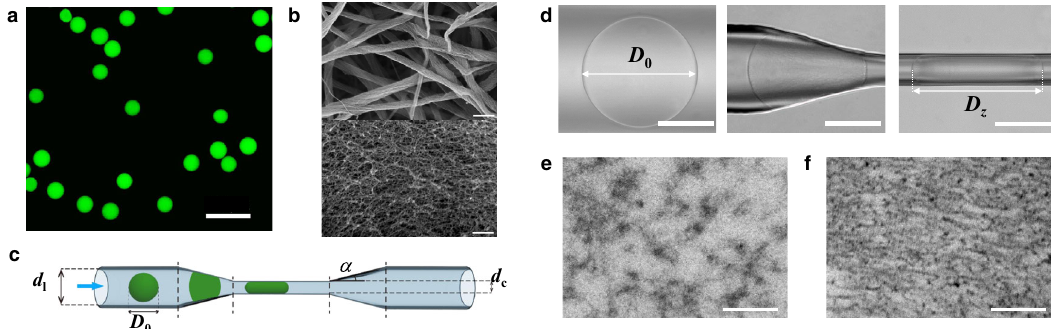
Fig. 1 Properties of fi brin microgels. a Fluorescence microscopy image of fl uorescein isothiocyanate (FITC)-labeled RMs suspended in TBS. The scale bar is 500 μ m. b SEM images of the SM (top) and RM (bottom). The scale bars are 500 nm. c Schematic of the micro fl uidic channel containing a channel-at- large (diameter of d l ) and a constriction with the entrance angle, α , of the tapered region of 15° and a diameter, d c = 65 μ m. d Left-to-right: optical microscopy images of RM (diameter of D 0 ) in the channel-at-large, the tapered zone, and in the constriction (length of con fi ned gel of D z ). The scale bars are 100 μ m. e , f TEM images of the undeformed RM ( e ) and occlusive RM ( f ), following its one-hour con fi nement in the constriction at 1/ λ r = 2.7, subsequent release, and fi xing with 5 wt% solution of glutaraldehyde in TBS. The diameter of the undeformed RM was 176 μ m. The scale bar is 100